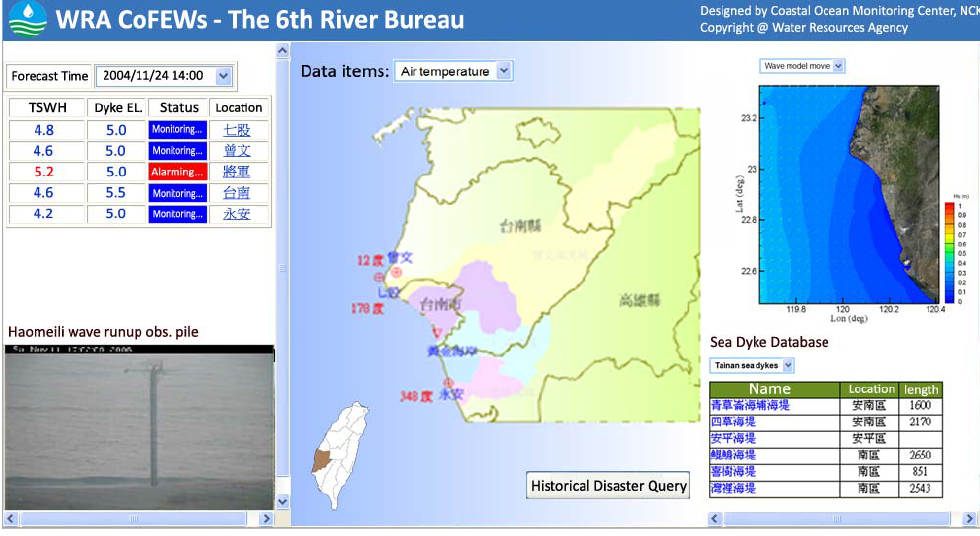
Figure 13 Regional system of CoFEWs – Page for the 6 th River Bureau Fig. 13. Regional system of CoFEWs – Page for the 6th River